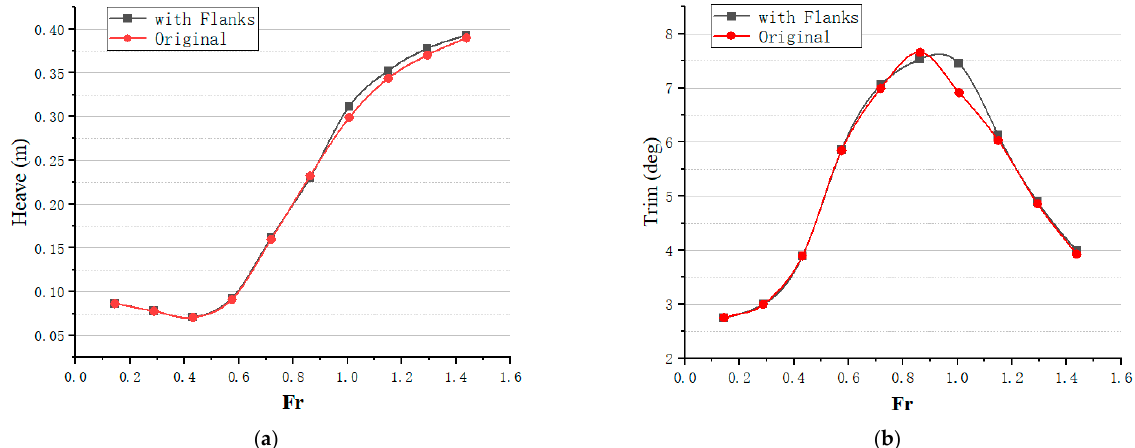
Figure 14. Comparison of Heave and Trim of the two schemes. ( a ) Heave, ( b ) Trim.